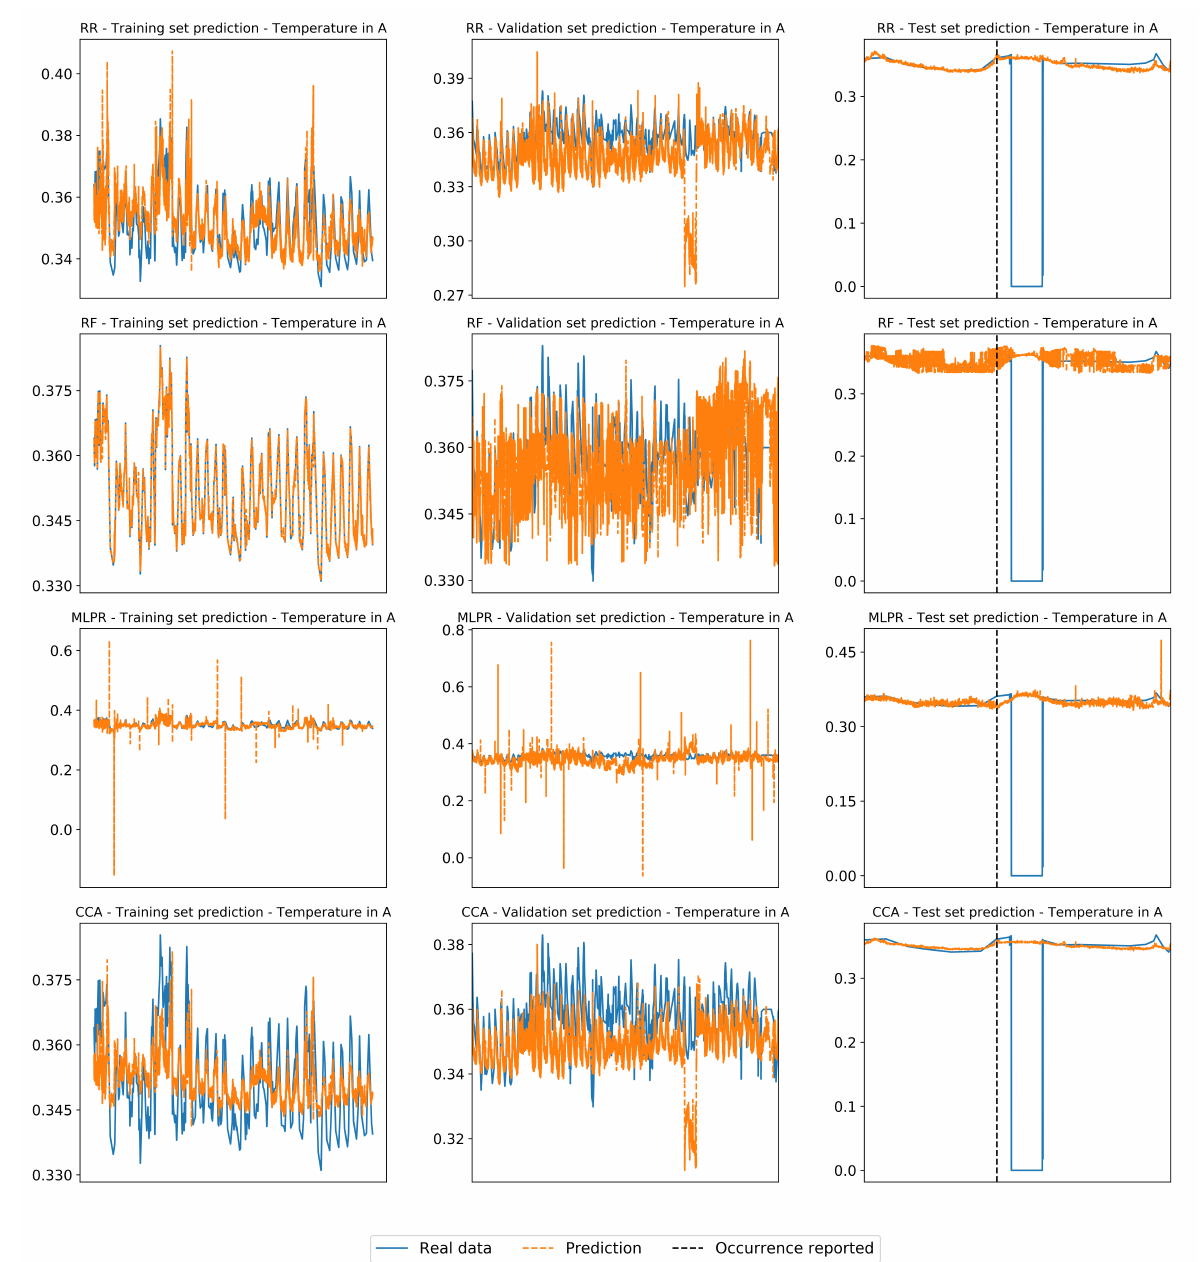
Figure 6. Regressors prediction for dimensionless Temperature in fiscal meter 02A (Section A) along Fault-FIII when the PCStable algorithm (partial correlation) with MCI (conditional mutual information) was used as the variable selection